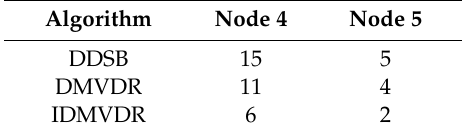
Table 1. The numbers of iterations when converging in the WASN with N d = 5. Algorithm